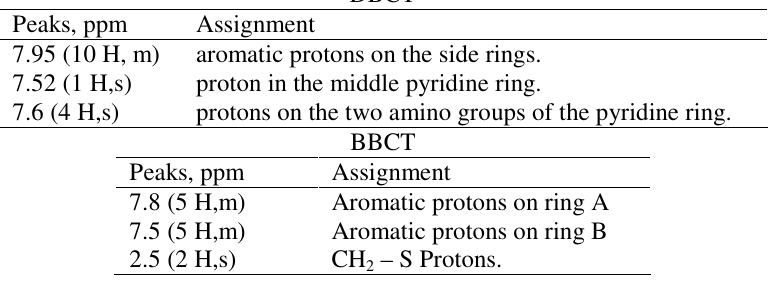
Table 6 . 1 H NMR data of ligands